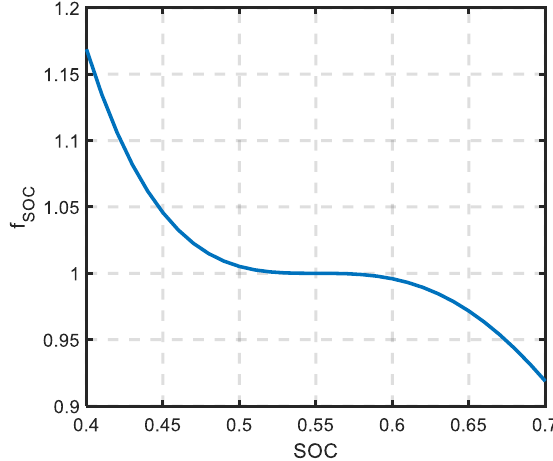
Figure 5. The variation of the penalty factor with SOC.